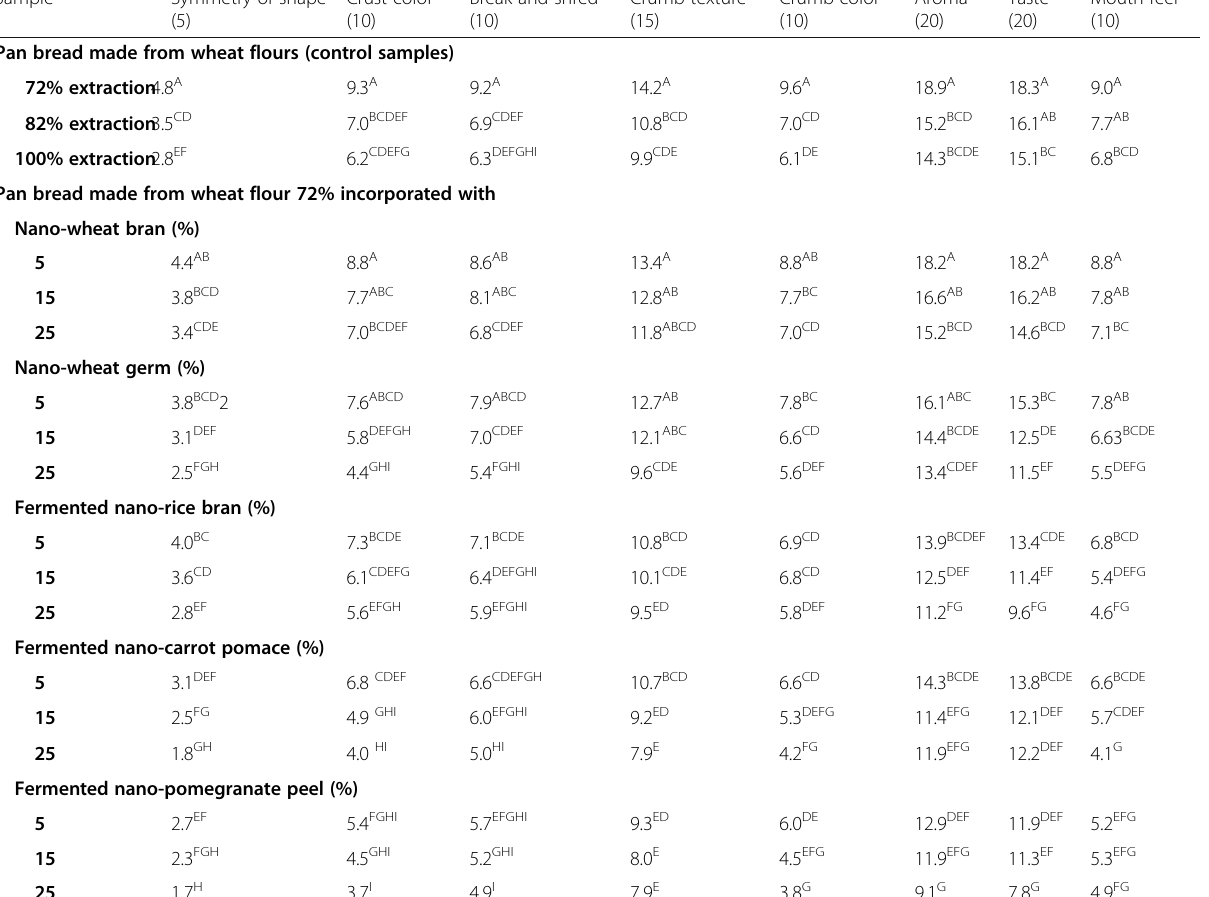
Table 2 Organoleptic characteristics of pan bread as affected by addition of nano and fermented nano materials